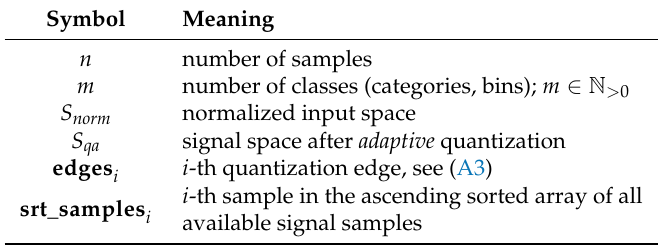
Table A1. Notation used in quantizaton Equations